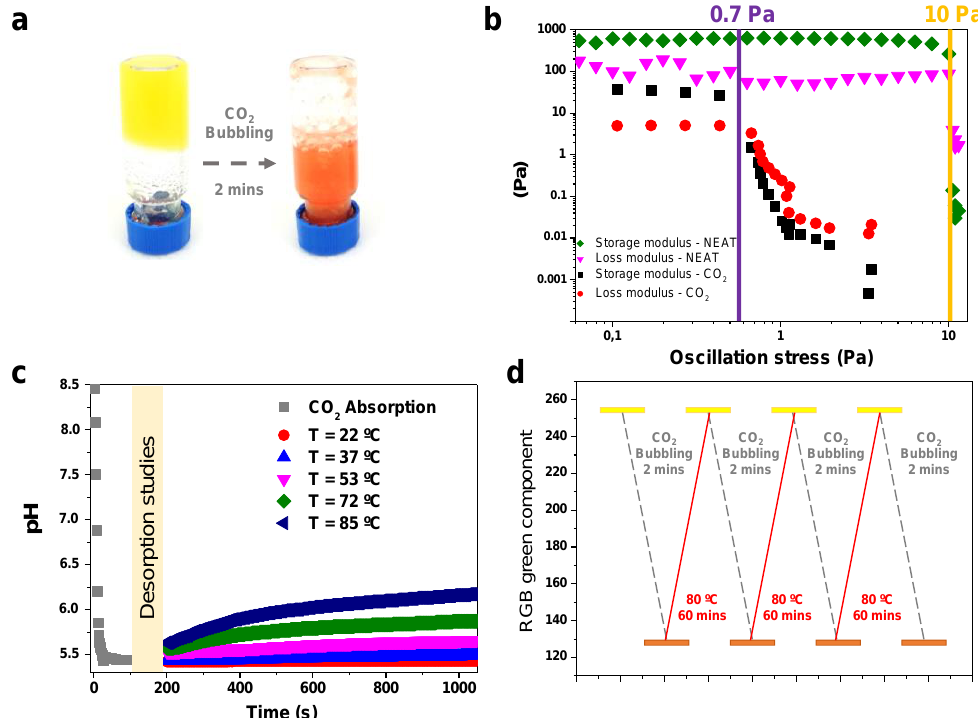
Figure 6. ( a ) A vial inversion test for the methyl red with the samples before (left) and after (right) CO 2 incorporation (1 mg of 6b in 1 mL of H 2 O(methyl red):DMSO (90:10)). ( b ) The storage and loss modulus representation for neat (green and pink, respectively) and CO 2 -rich (black and red, respectively) samples; the oscillation stress required for the gel-to-liquid transition is highlighted in purple for the CO 2 -rich sample and in orange for the freshly prepared 6b hydrogel. ( c ) CO 2 absorption/desorption results obtained via in-line monitorization of the pH for the 6b gel (1 mg in 1 mL of H 2 O:DMSO, 90:10). ( d ) Cycles for the CO 2 absorption/desorption – hydrogel depletion/formation obtained for 6b by measuring the RGB green component observed (1 mg of 6b in 1 mL of H 2 O:DMSO, 90:10).